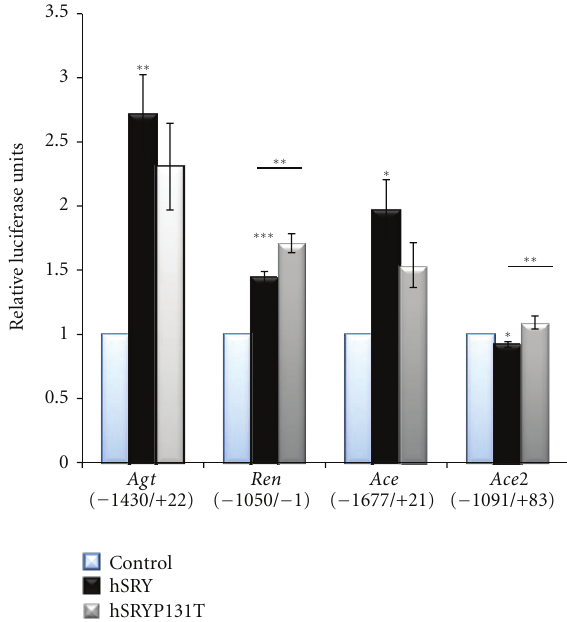
Figure 3: Human SRY regulation of rat RAS gene promoters. Human SRY (black) increases promoter activity of rat Agt, Ren , and Ace while decreasing Ace2 as previously seen with Sry1 and Sry3. Mutations to the proline 131 of hSRY to threonine (gray) significantly increased activity in Ren and Ace2 while they had a trend in decreasing activity on Agt and Ace . Significance of hSRY is based on comparison to the control vector (blue) or for hSRY P131T to the hSRY values. ∗ P ≤ 0 . 05, ∗∗ P ≤ 0 . 01, ∗∗∗ P ≤ 0 .